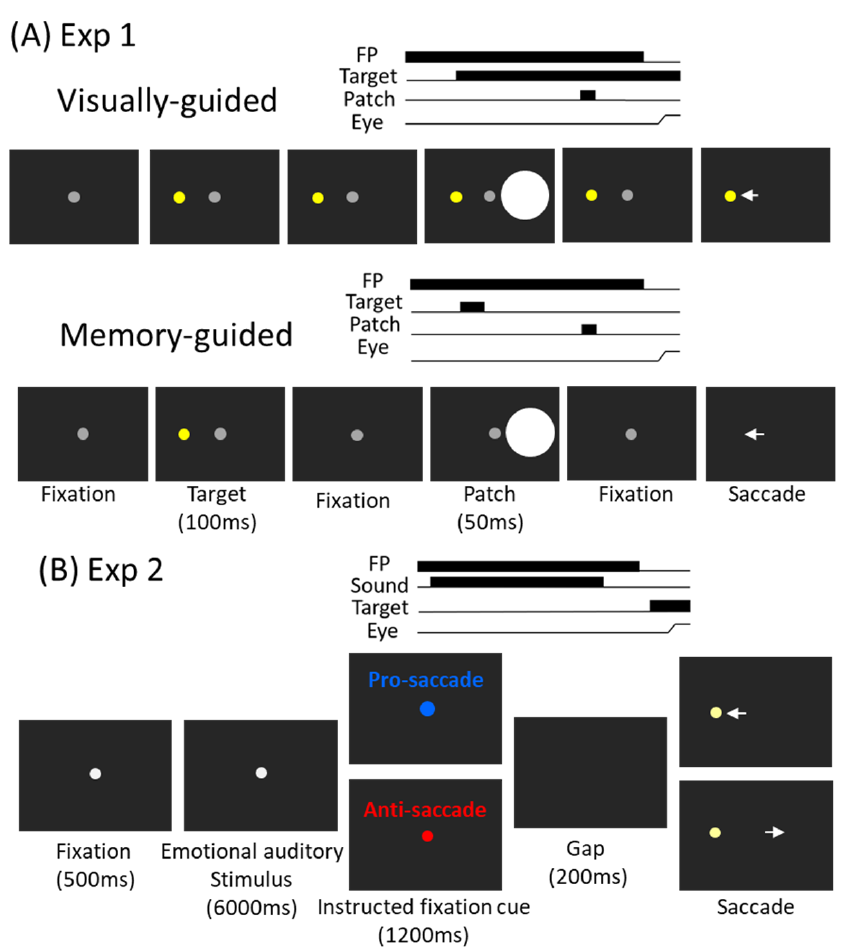
Figure 1. ( A ) Experiment 1 paradigm . Each trial started with a central fixation point on a black background. After a delay, there was a presentation of a target stimulus, and after a random delay the central fixation point disappeared and participants were required to move their eyes to the tar- get. During the delay period, a bright circular patch stimulus was presented briefly (50 ms), with the patch being spatially aligned with the target location or the opposite location of the target. The